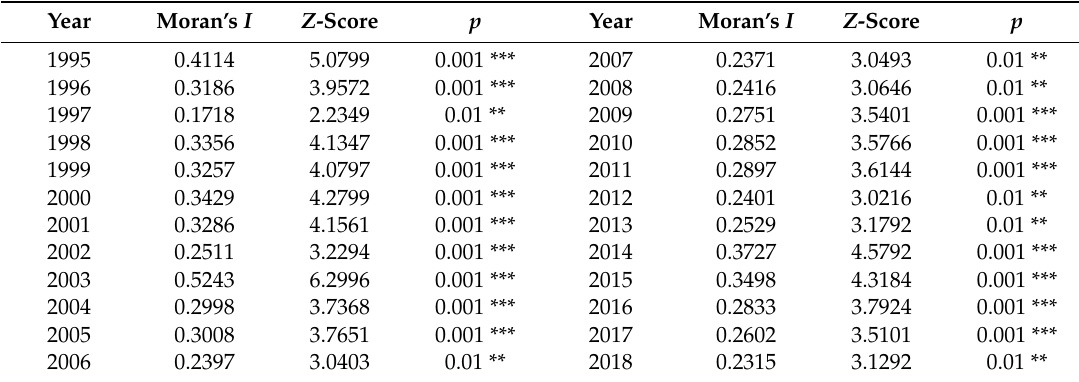
Table 3. Moran’s I value of grain production in